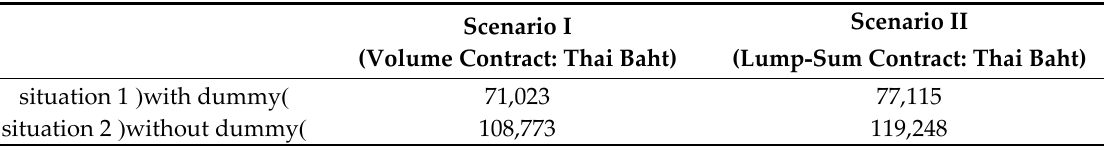
Table 2. The optimal transportation cost in two situations